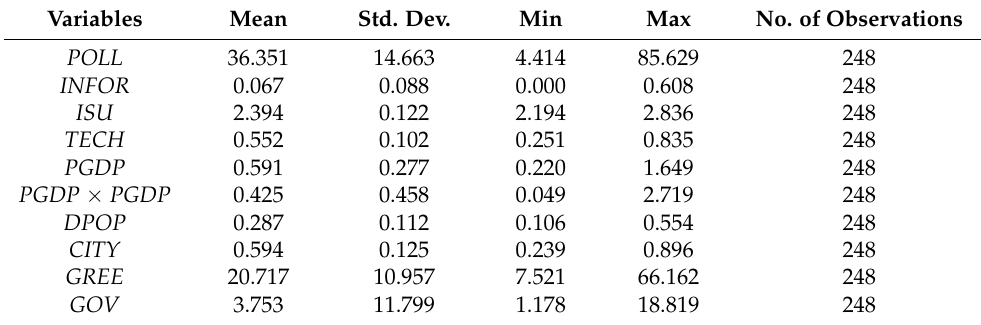
Table 2. The descriptive statistical analysis results of main